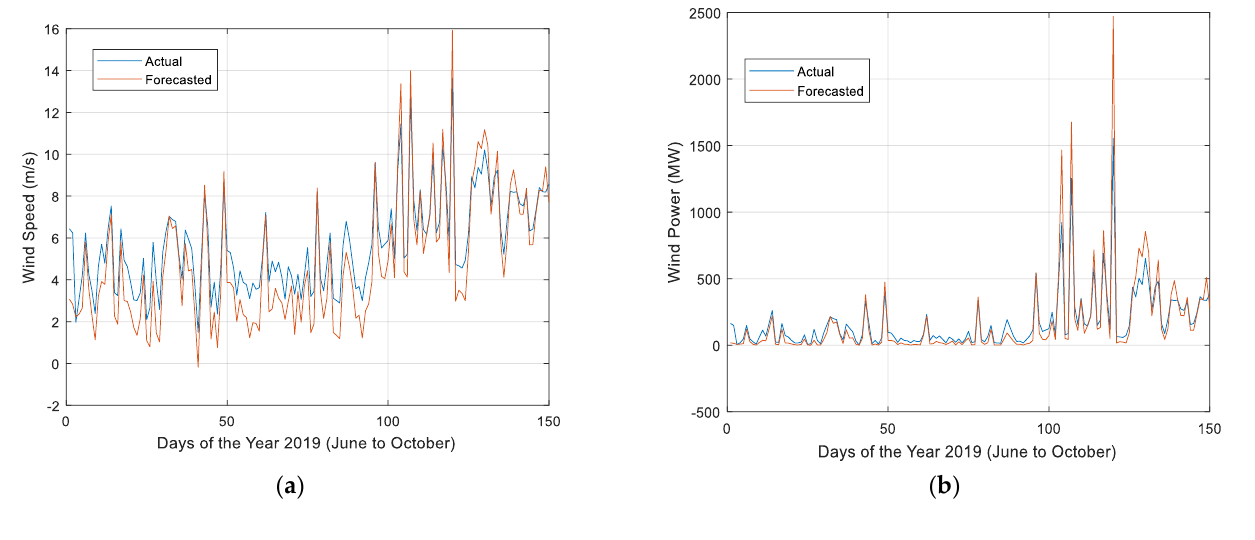
Figure 14. ( a ) Comparative analysis of wind speed forecasting by the CFNN trained through MHPSO-BAAC. ( b ) Comparative analysis of wind power forecasting by the CFNN trained through MHPSO-BAAC.